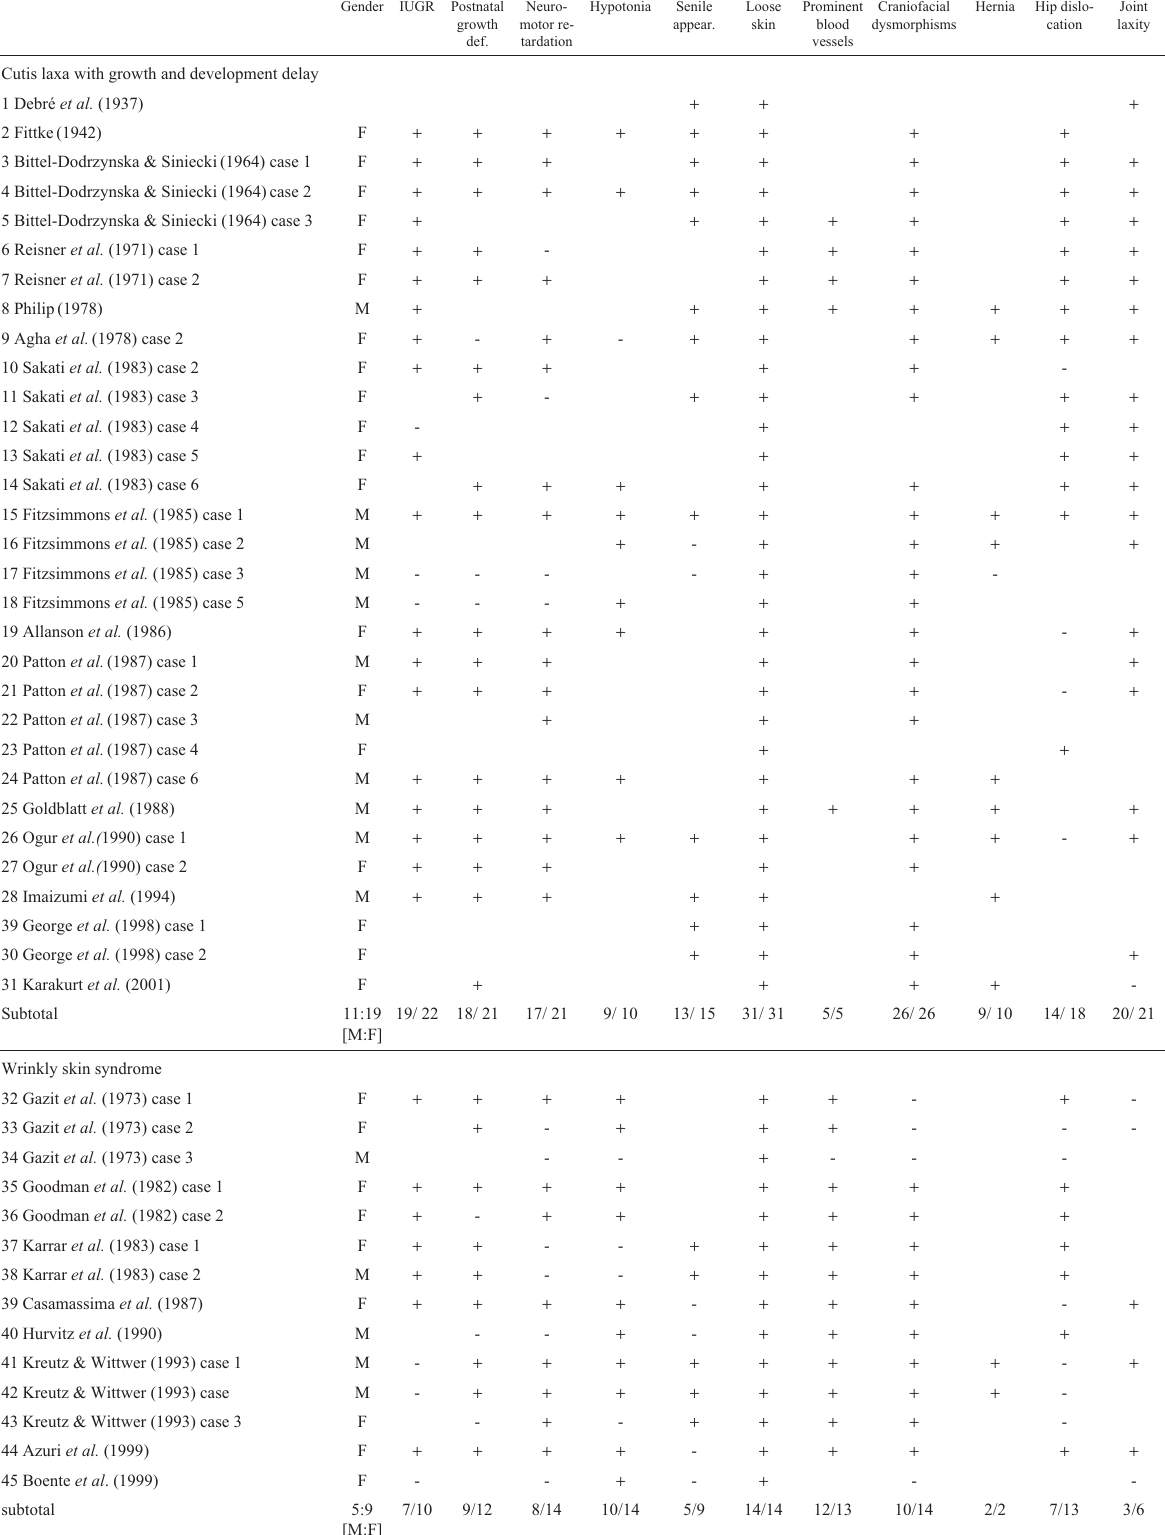
Table 2 - Main clinical features of cutis laxa with growth and developmental delay (CLGDD), Geroderma osteodysplastica (GO) and wrinkly-skin syndrom (WSS) according to descriptions in published papers. Gender IUGR Postnatal